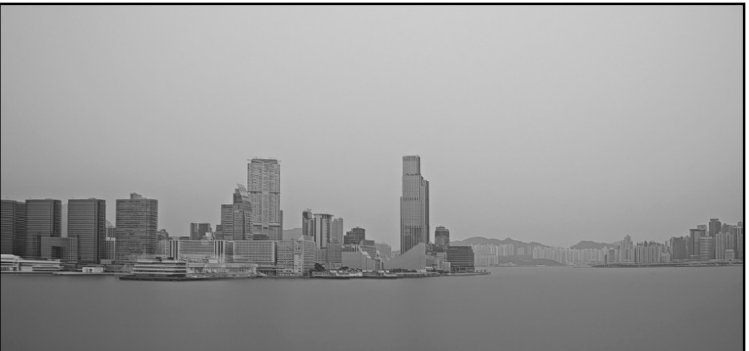
Figure 4. Comprehensive image after gray weighted average.